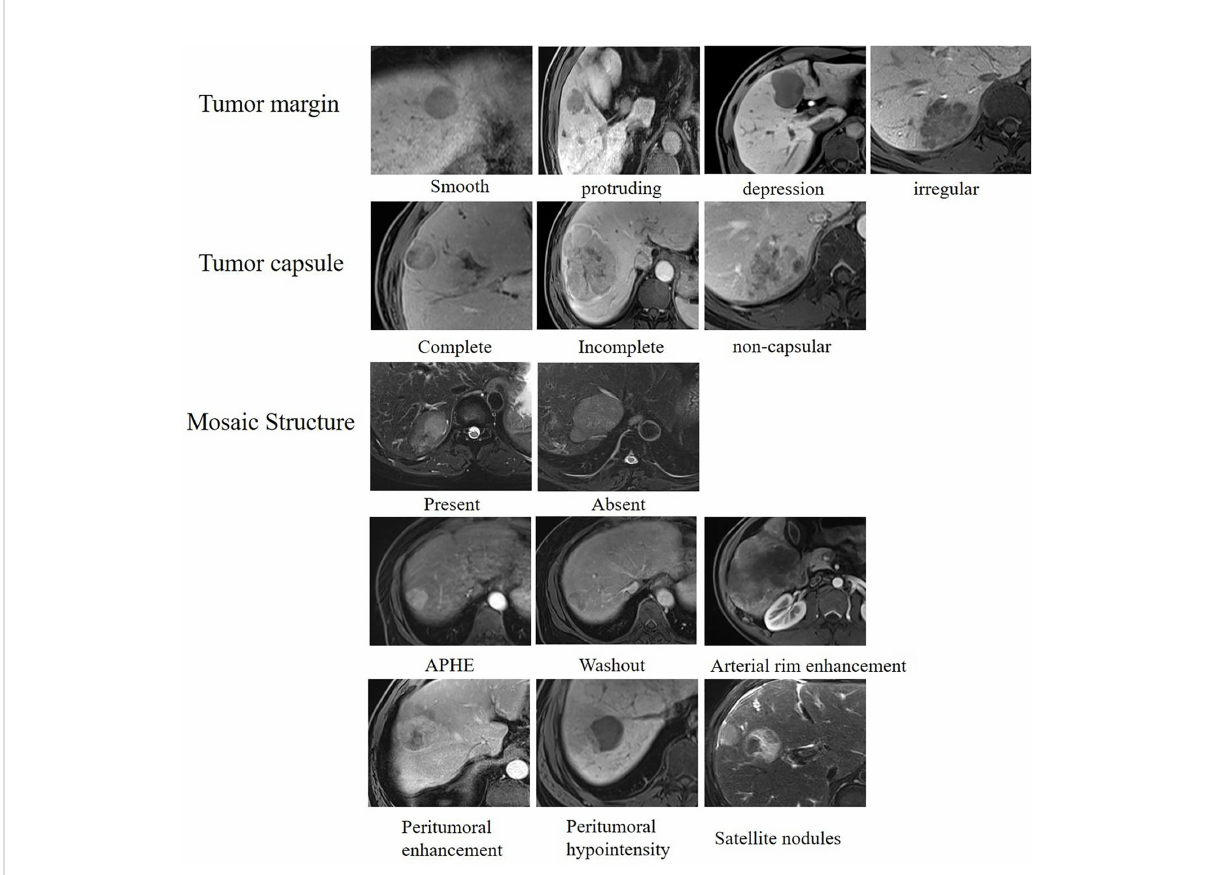
FIGURE 3 Qualitative features of hepatocellular carcinoma. Assessment of qualitative features including tumor margin, tumor capsule, mosaic structure, APHE, washout, arterial rim enhancement, peritumoral enhancement, peritumoral hypointensity, and satellite